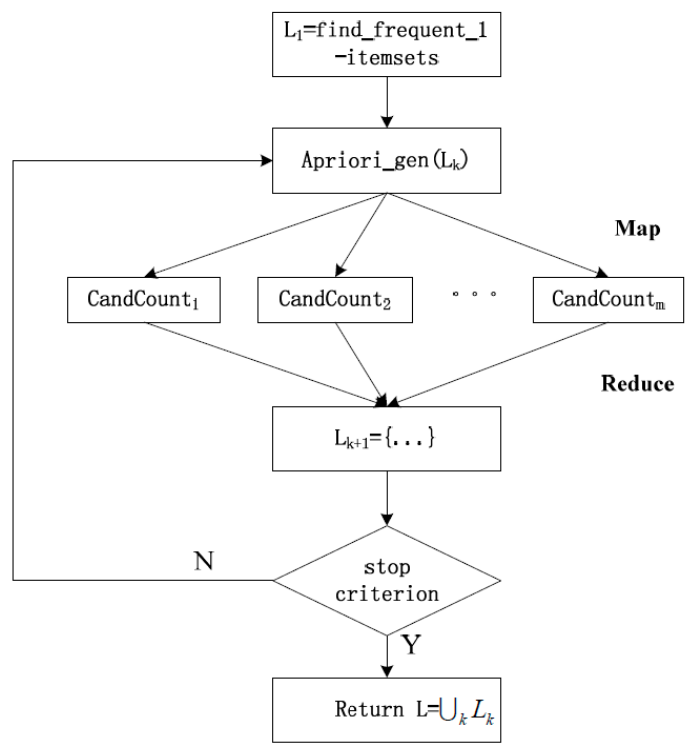
Figure 2. Map-Reduce Apriori Algorithm [11] .